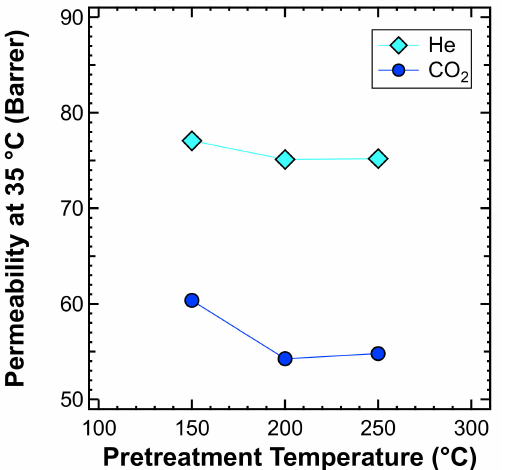
Figure 8. E ff ect of the thermal annealing temperature on the pure PPO permeability at 35 ◦